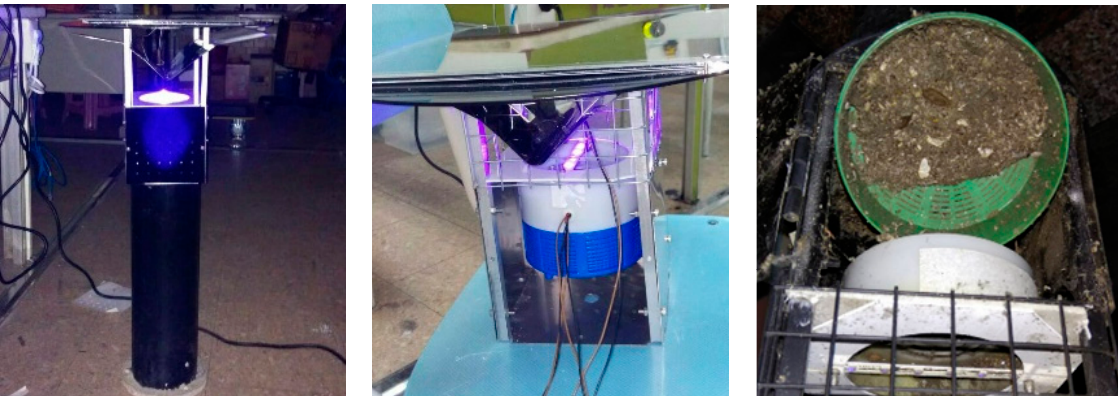
Figure 9. Proposed mosquito trapping system with a bird-wing optical reflector and its mosquito-trapping results.